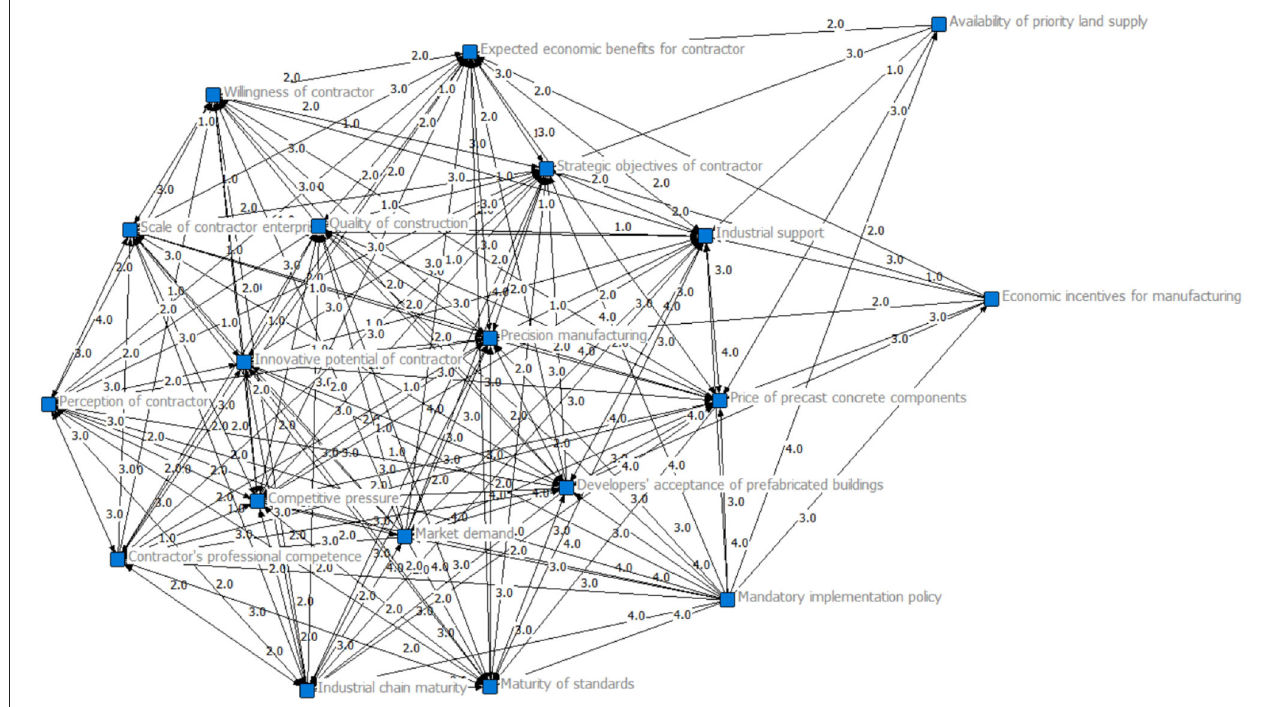
FIGURE 1 | Visual model of influencing factors in a relationship network.